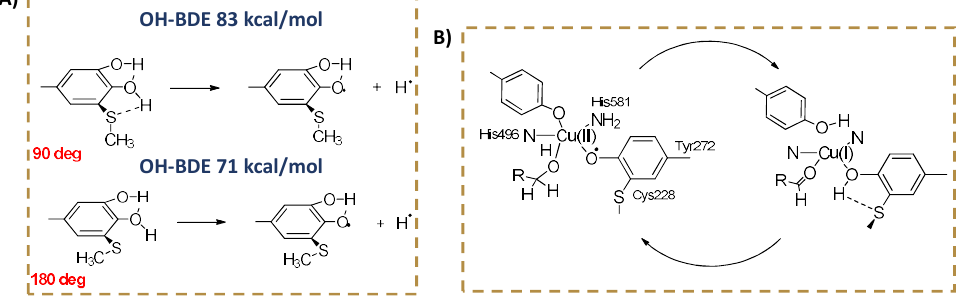
Figure 1. ( A ) Stereo-electronic effects of a hypothetical ortho -SCH 3 substituent on the BDE of a phenol. In red are shown the Ar-SMe dihedral angles. ( B ) Active site of the enzyme Galactose Oxidase, featuring a covalent Tyr-Cys linkage.